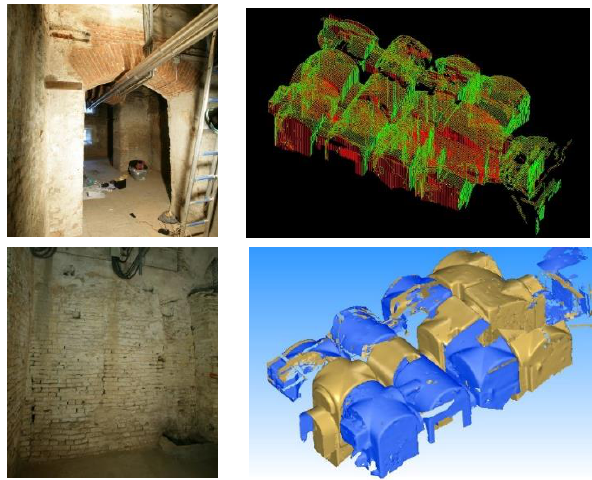
Figure 4. Photos from the ancient structure and image of the section elaboration and mesh creation